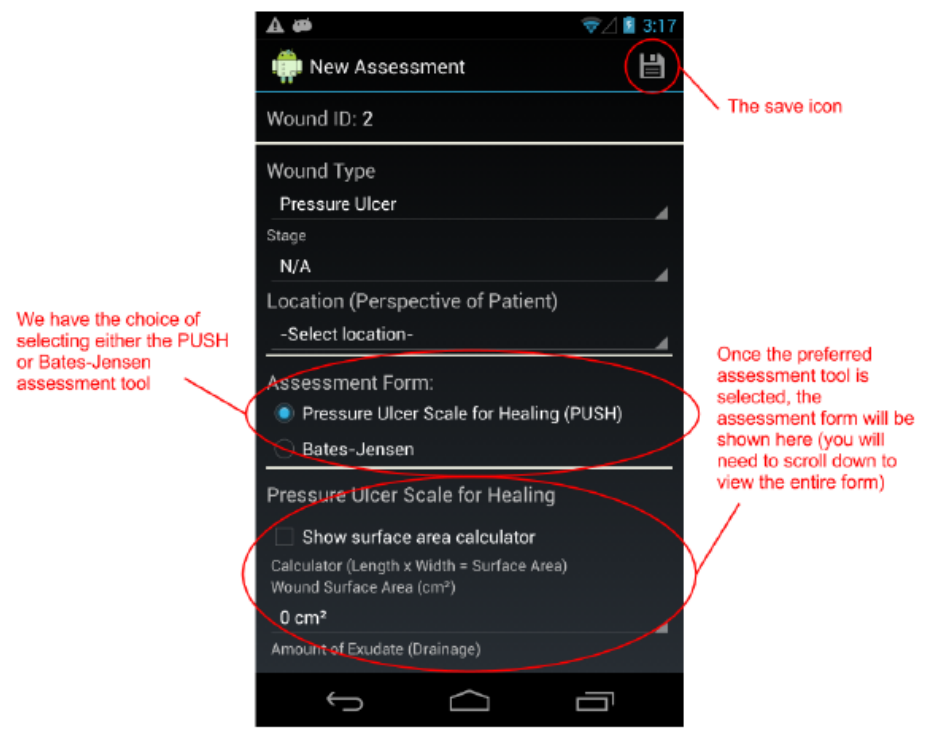
Figure 5. The top of the New Assessment screen. We have the choice of selecting either the PUSH or Bates-Jensen assessment tool to assess a pressure ulcer.